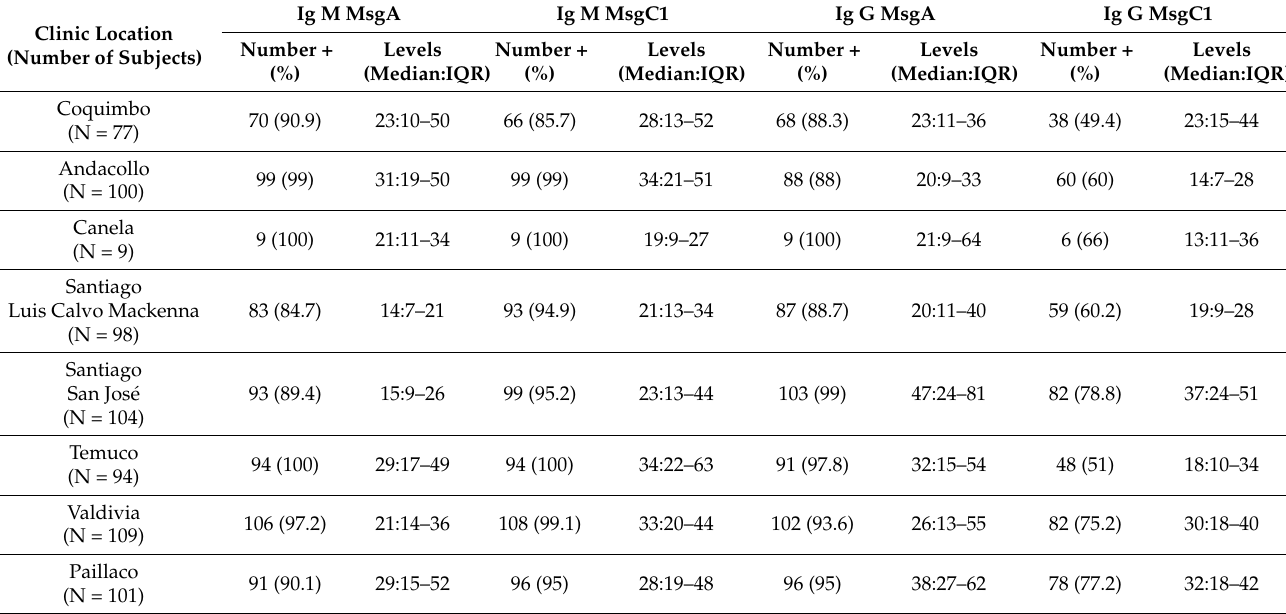
Table 1. Ig M and Ig G antibody responses to Pneumocystis MsgA and MsgC1 constructs in infants and children.